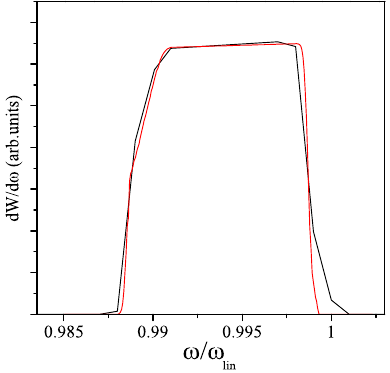
FIG. 4. Angle-integrated spectrum dW=d! vs !=! lin for (cid:1) ¼ 200 , (cid:9) acc ¼ 500 (cid:10) rad , a 0 ¼ 0 : 06 , w 0 ¼ 27 (cid:10) m . Black curve: nonlinear calculation; red curve: linear